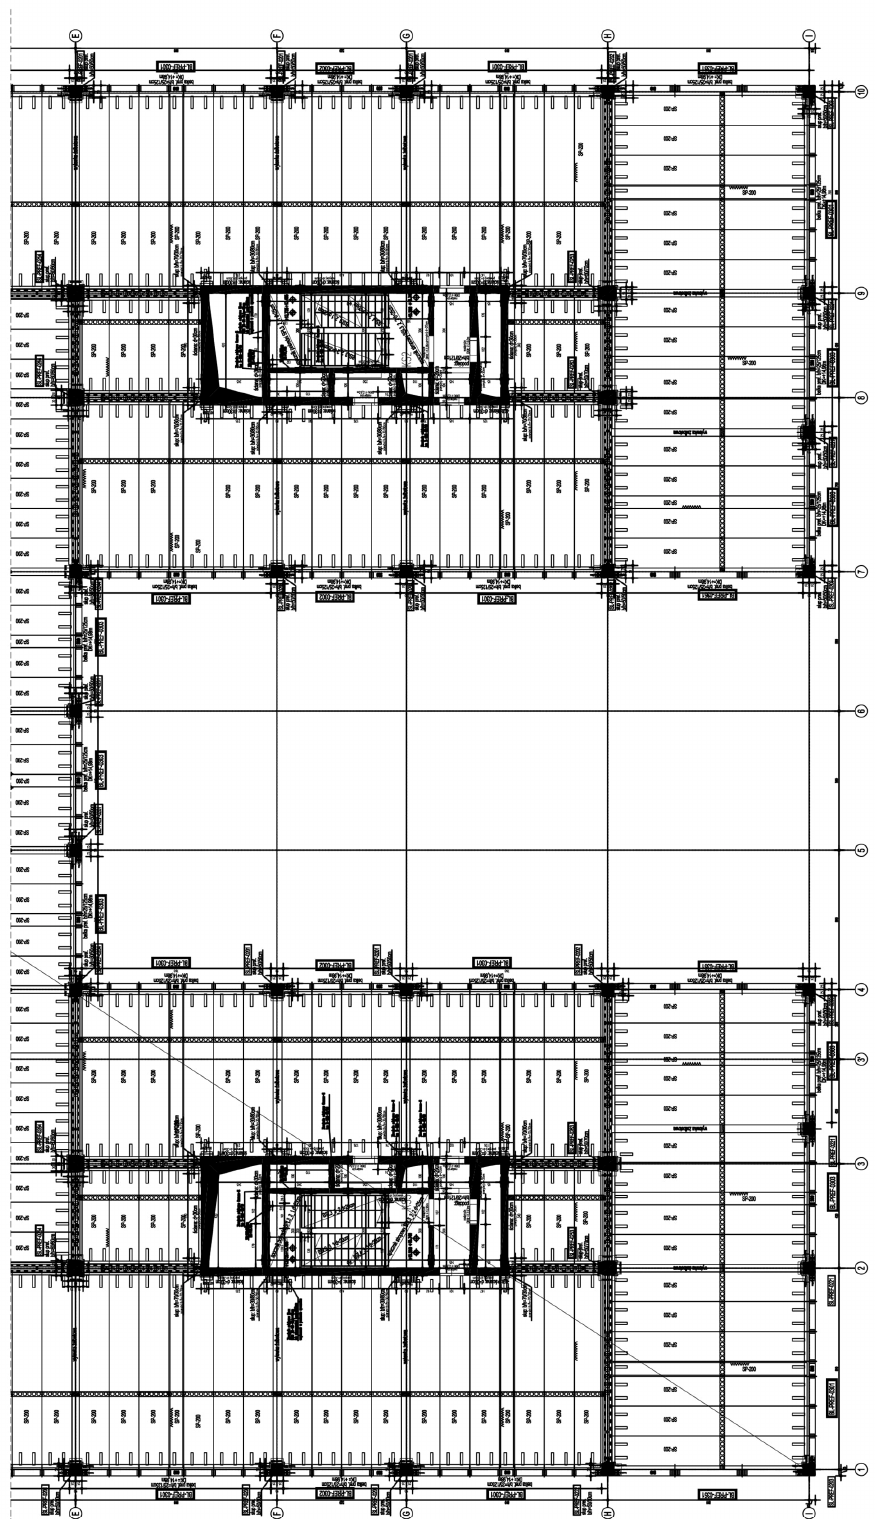
Figure 4. The Green2Day building slabs’ layout—Part 2. The design drawing was obtained from Grupa Projektowa Konstruktor Ltd.